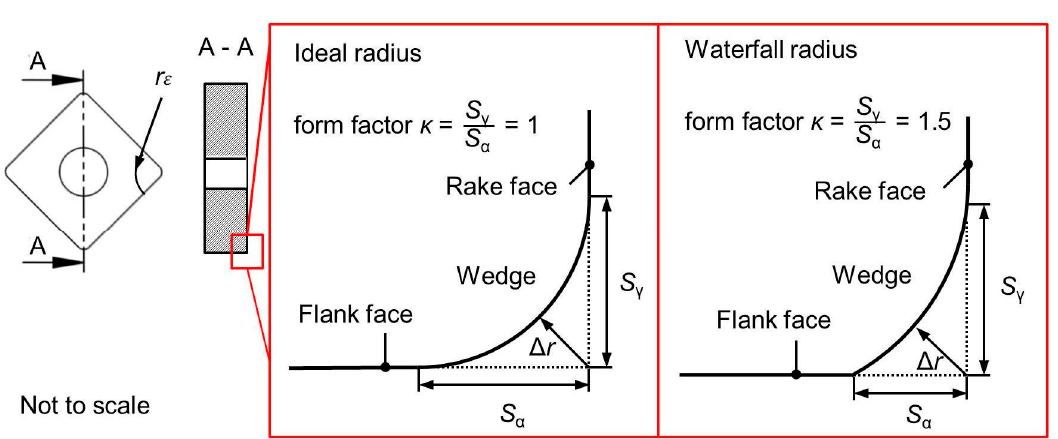
Figure 3. Form-factor method for ideal radius and waterfall radius.